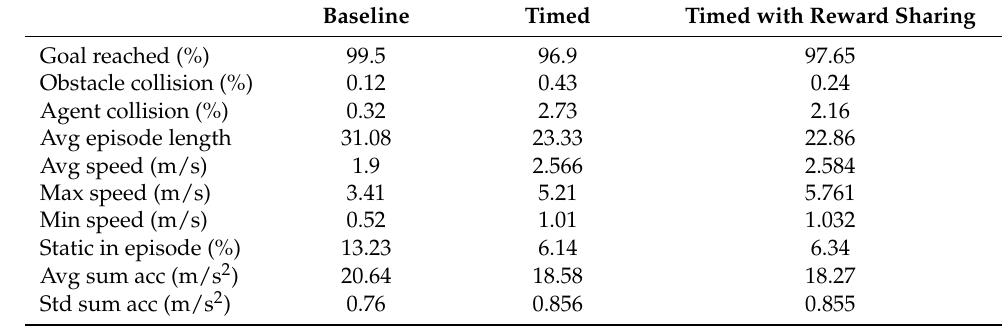
Table 2. Performance evaluation of the three setups of crossroad environments. In the Baseline , the agents were rewarded purely for reaching their goals. In the environment Timed , the reward depended on the mean speed in the episode, while the last environment, Timed with shared reward recreated the reward mechanism but added the reward-sharing mechanism. The characteristics related to the duration, speed, and acceleration of the episode were calculated only for the agents who achieved the goal successfully. Baseline Timed Timed with Reward Sharing Goal reached (%) 99.5 96.9 97.65 Obstacle collision (%) 0.12 0.43 0.24 Agent collision (%) 0.32 2.73 2.16 Avg episode length 31.08 23.33 Avg speed (m/s)